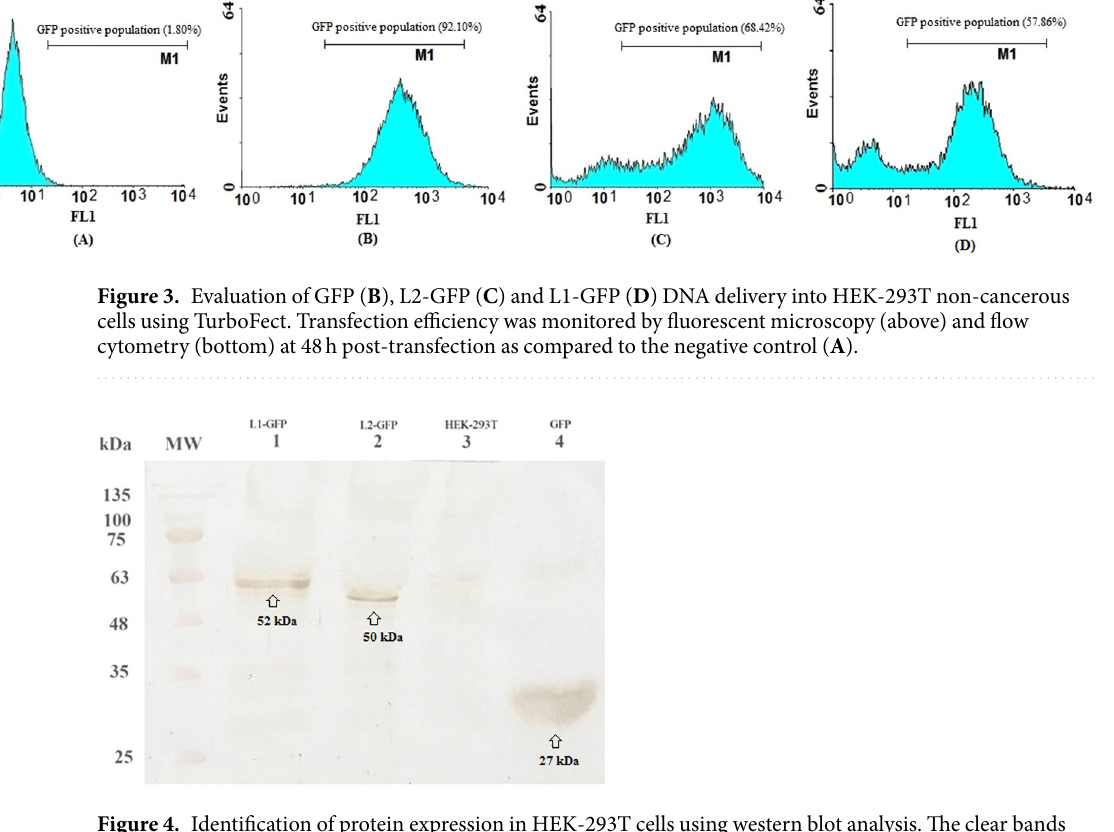
GI: 333048.L2), 33 (GI: 333049.L1 and GI: 333049.L2), 35 (GI: 396997.L1 and GI: 396997.L2), 39 (GI: 333245.L1 and GI: 333245.L2), 45 (GI: 397022.L1 and GI: 397022.L2), 51(GI: 333087.L1 and GI: 333087.L2), 52(GI: 397038. L1 and GI: 397038.L2), 56 (GI: 397053.L1 and GI: 397053.L2), 58 (GI: 222386.L1 and GI: 222386.L2), 59 (GI: 557236.L1 and GI: 557236.L2, and 68(GI: 71726685.L1 and GI: 71726685.L2)] were extracted from PaVE data- base (https://pave.niaid.nih.gov/) and used as input for future bioinformatics analysis. Protein alignments and conservancy analysis. To determine conserved epitopes between different subtypes, L1 and L2 sequence datasets were first aligned using SnapGene software 4.2.2 (From GSL Biotech; available at snap- gene.com). After protein alignments analysis using muscle algorithms, the conserved epitopes of each protein were selected for immune-bioinformatics analysis such as B- and T-cell epitope prediction. Also, to calculate the degree of variability and conservancy of each epitope, IEDB epitope conservancy tools (http://tools.immuneep- itope.org/tools/conservancy/) were used. Linear B-cell epitope prediction. A successful vaccine must elicit a strong T-cell and B-cell immune response, but above all, provide protection against the disease being targeted. Therefore, it is essential to show that constructed immunogens are able to induce protective cellular and humoral immunity. Since the antibodies are induced against linear B-cell epitopes, it would be very difficult to synthesize long peptides with the native protein confor- mation resembling for the induction of protective antibodies. However, optimal peptide-based vaccines should be presented in a desired secondary structure of peptides in order to induce a specific humoral response 41,42 . For the B-cell epitope prediction of conserved regions in L1 and L2 proteins, BepiPred-2.0 server (http://www.cbs.